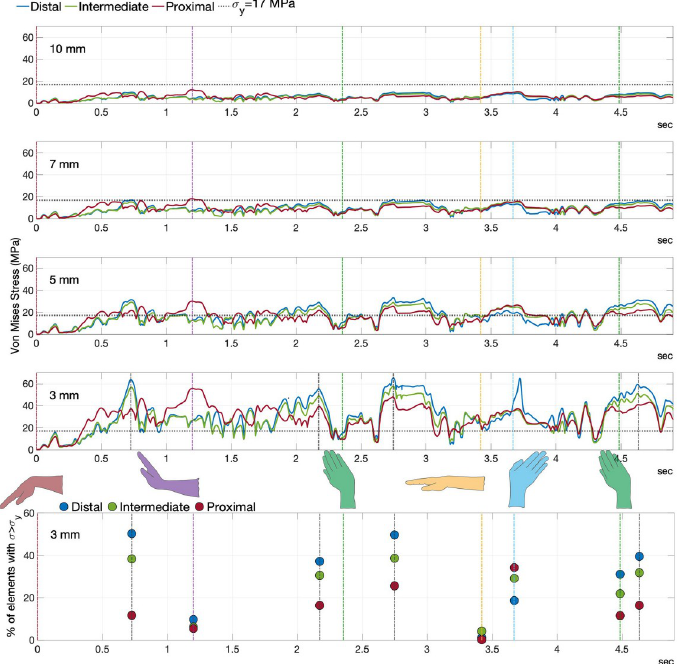
Fig 12. Summary of von Mises stress. The 10-, 7-, 5- and 3-mm ligament-scaffold inserted at distal (Fig 5b), intermediate (Fig 5c), and proximal (Fig 5d) surgical sites. The von Mises stress depicted maximum values of stress distribution in ligament-scaffold. The percentage of mesh elements exceeding critical stress ( σ y = 17 MPa) for 3 mm ligament-scaffold length was calculated at times 0; 1.11; 2.355; 3.42; 3.67 and 4.485 seconds, which correspond to flexion (red), extension (purple), radial deviation (green), neutral (yellow), ulnar deviation (cyan) and radial deviation (green),